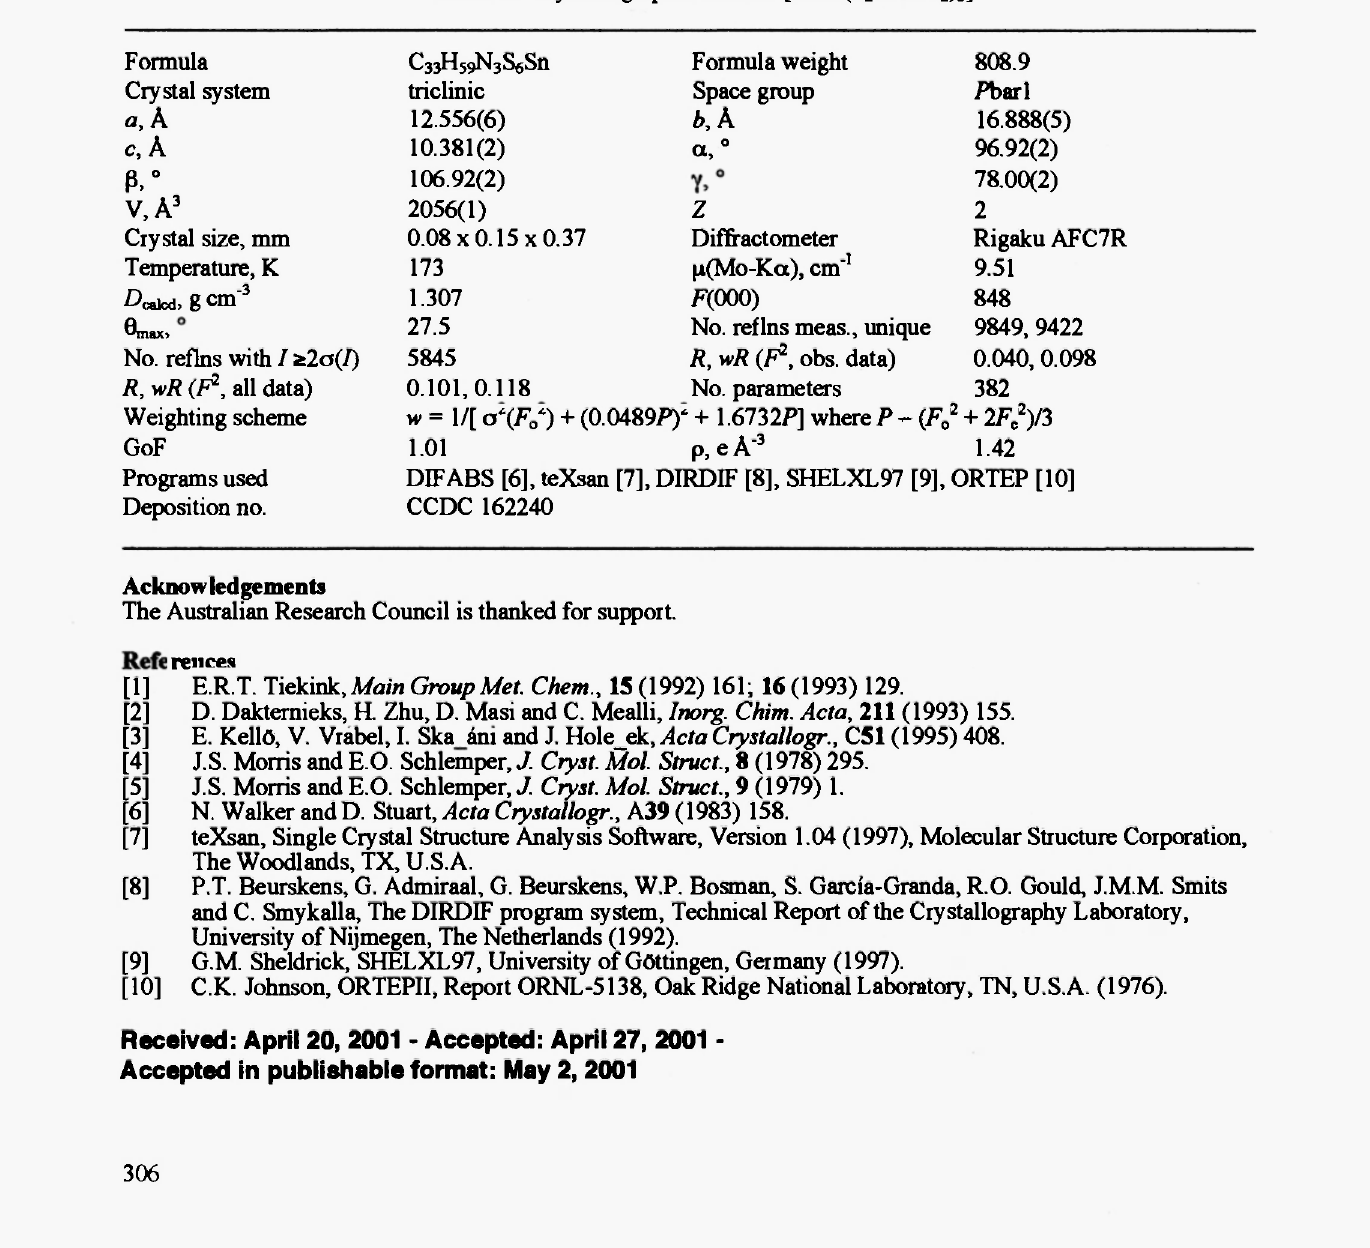
Table 1. Crystallographic data for [PhSn(S